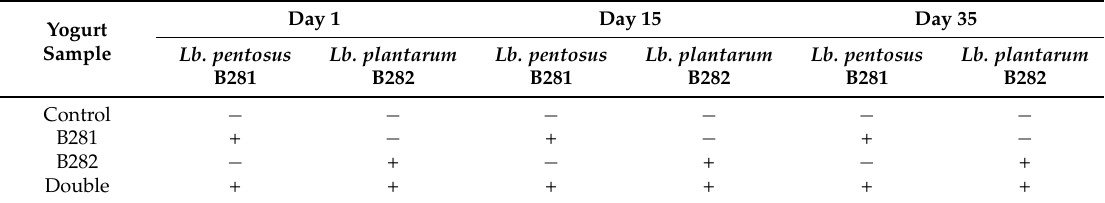
Table 1. Detection of Lb. pentosus B281 and Lb. plantarum B282 in yogurt samples at levels ≥ 6 log CFU/g, after 1, 15, and 35 days of storage at 4 °C. Detection was performed by cell enumeration and multiplex polymerase chain reaction (PCR) analysis.